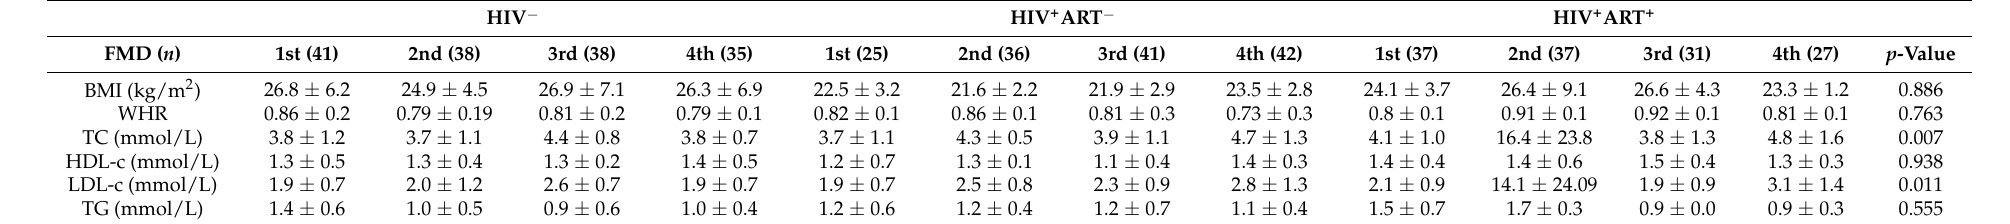
Table 4. Relationship between ART, endothelial function and cardiovascular risk